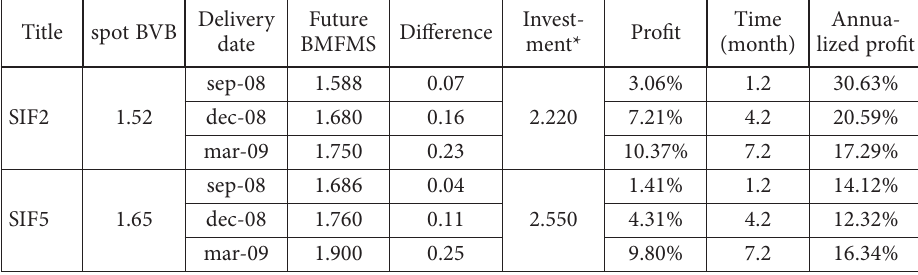
Table 1. Arbitrage opportunities on Romanian market (source: own processing) Delivery spot BVB